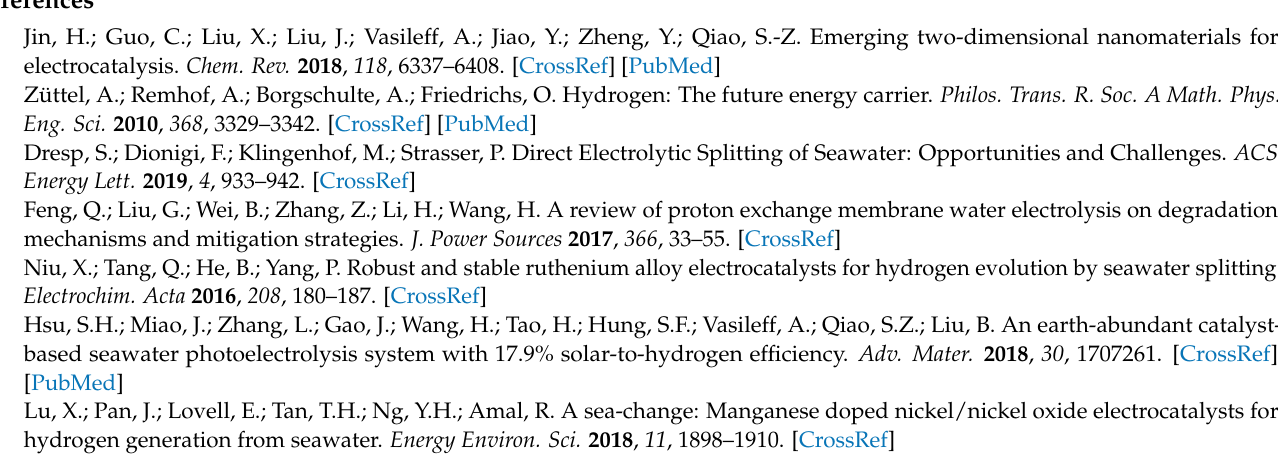
Figure S2: SEM images of (Co,Fe)OOH on iron foam, Figure S3: SEM images of (Co,Fe) 3 O 4 on iron foam, Figure S4: (a) TEM image of (Co,Fe)OOH with selected area electron diffraction (SAED) ring patterns (insert), and (b) TEM-EDS mapping images of (Co,Fe)OOH, Figure S5: (a) TEM image of (Co,Fe) 3 O 4 with selected area electron diffraction (SAED) ring patterns (insert), and (b) TEM-EDS mapping images of (Co,Fe) 3 O 4 , Figure S6: TEM-EDS mapping of (Co,Fe)PO 4 , Figure S7: EDX spec- trum of (Co,Fe)PO 4 , Figure S8: Cyclic voltammetry curves of (a) (Co,Fe)OOH, (b) (Co,Fe) 3 O 4 , and (c) (Co,Fe)PO 4 in non-Faradaic region at different scan rates 10–160 mV/s, Figure S9: Double layer capacitance (C dl ) of (a) (Co,Fe)OOH, (b) (Co,Fe) 3 O 4 , and (c) (Co,Fe)PO 4 , Figure S10: Polarization curves of NiFeOOH electrocatalysts for OER in 1 M KOH. To avoid interference with the oxida- tion current, a cell voltage of 10 mA/cm 2 was measured at the reverse-swept cyclic voltammetry, Figure S11: Polarization curves of NiFeOOH//(Co,Fe)PO 4 electrolyzer for overall seawater splitting compared to IrO 2 //Pt/C noble metal electrolyzer in 1 M KOH electrolyte. To avoid interference with the oxidation current, a cell voltage of 10 mA/cm 2 was measured at the reverse-swept cyclic voltammetry, Figure S12: Durability test of NiFeOOH//(Co,Fe)PO 4 electrolyzer conducted at con- stant current density of +100 mA/cm 2 for 50 h in 1 M KOH electrolyte, Figure S13: (a) SEM image and (b) XRD results of (Co,Fe)PO4 after durability test, Table S1: Comparison of overall water splitting performance of the NiFeOOH//(Co,Fe)PO 4 with recently reported transition metal-based alkaline water electrolyzers in 1 M